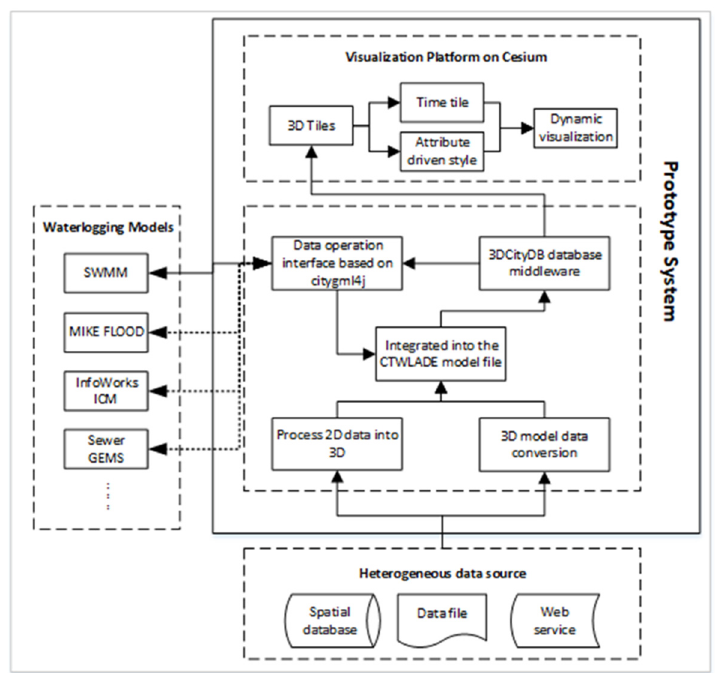
Figure 15. The processing flow of the prototype system.